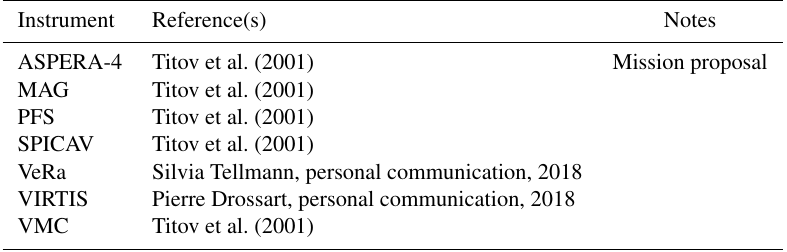
Table A9. Venus Express’s instruments and references for team members lists.